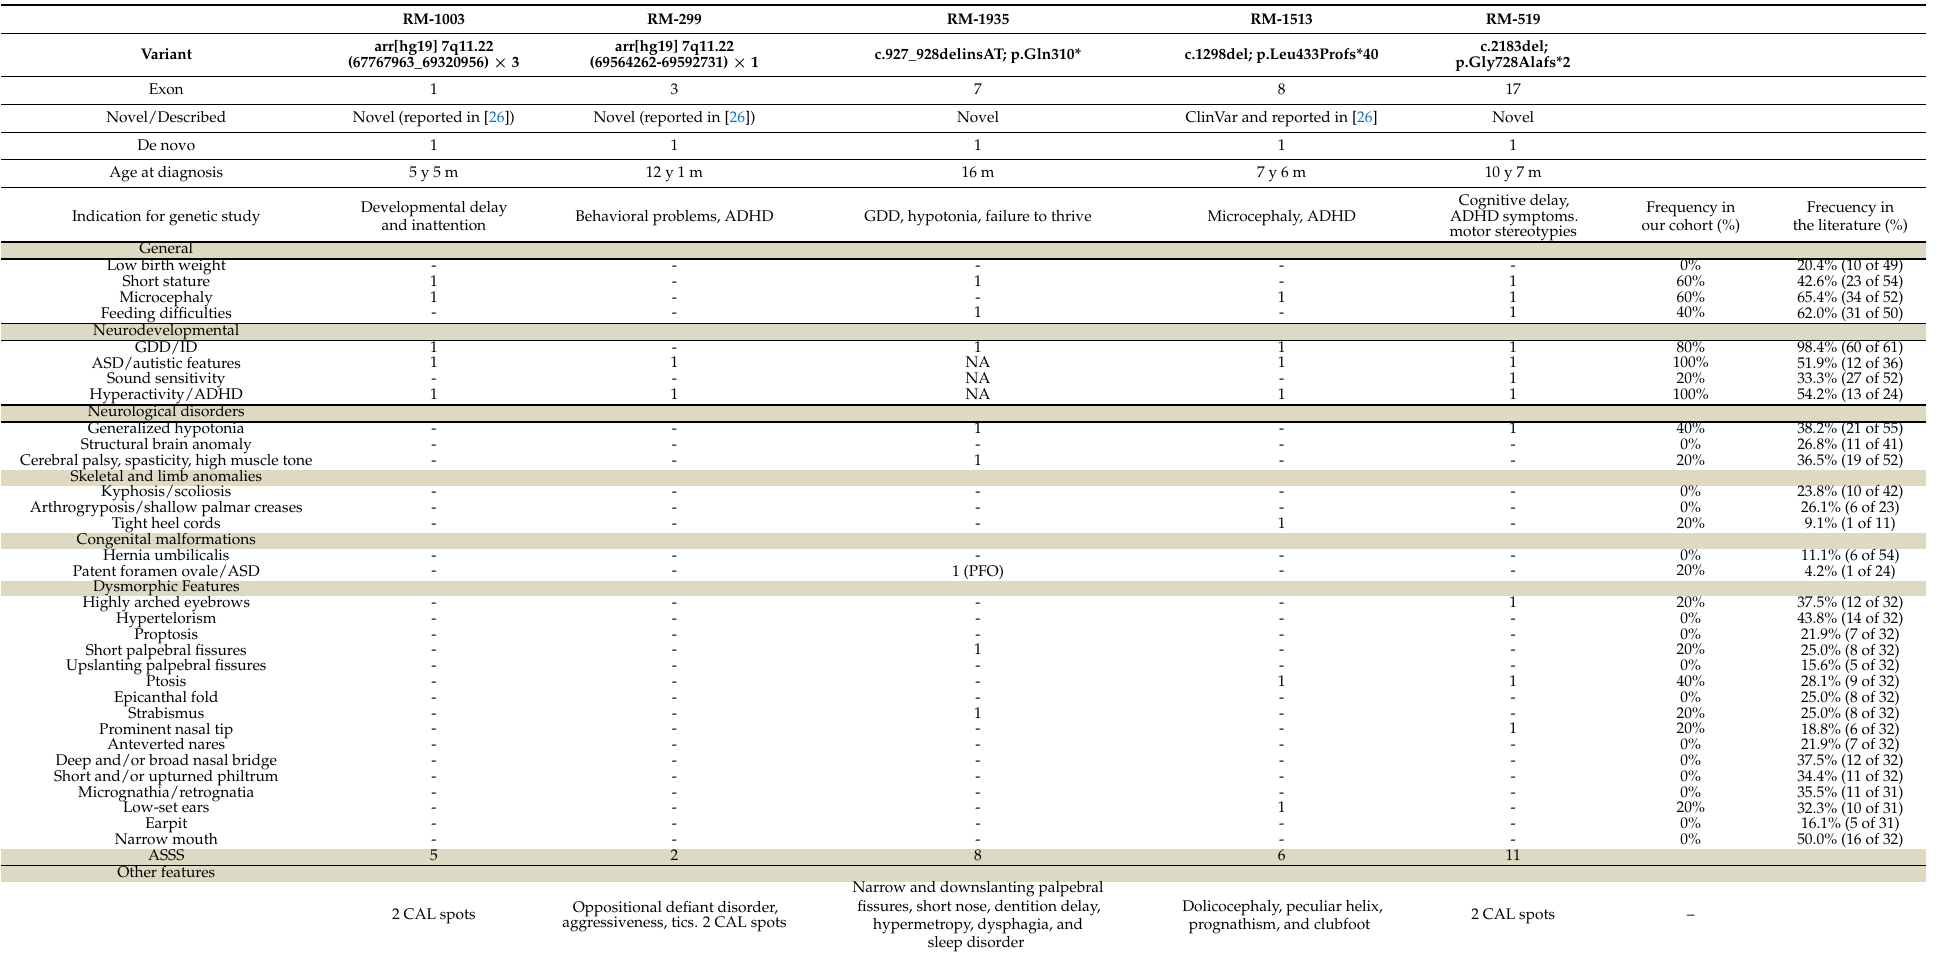
Table 1. Molecular and Clinical Characteristics of the Patients Included in the Study, Based on the ASSS List of Items. The frequency of the AUTS2 syndrome features in our cohort and the literature is also displayed. Data for the latter was extracted and calculated from (references). The ASSS from our patients is included at the end of the table. For the age at diagnosis, y = years and m = months. GDD = global developmental delay; ID = intellectual disability; ASD = autism spectrum disorders; ADHD = attention deficit/hyperactivity disorder; NA = not